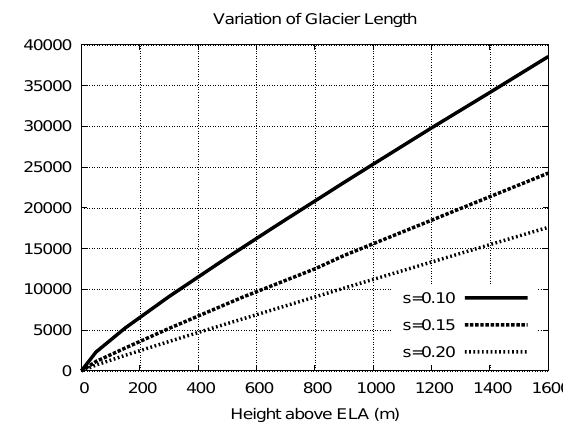
Fig. 9. Variation of equilibrium length as function of h e and s